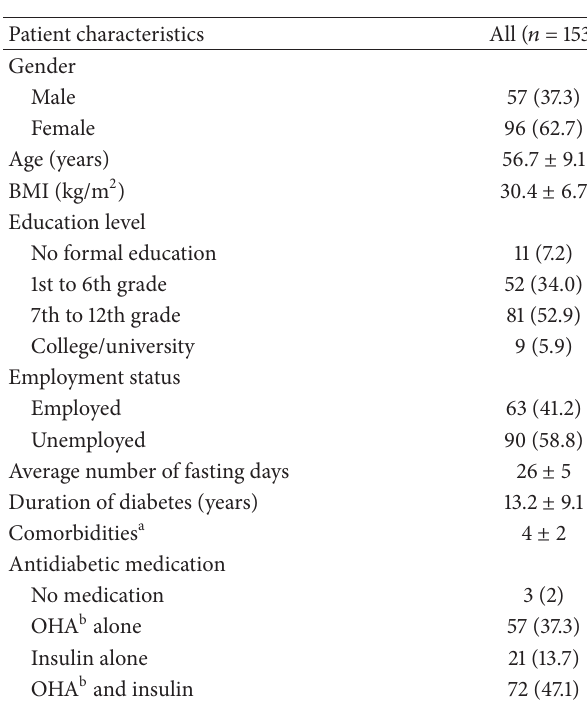
Table 1: Patient demographics and attributes.